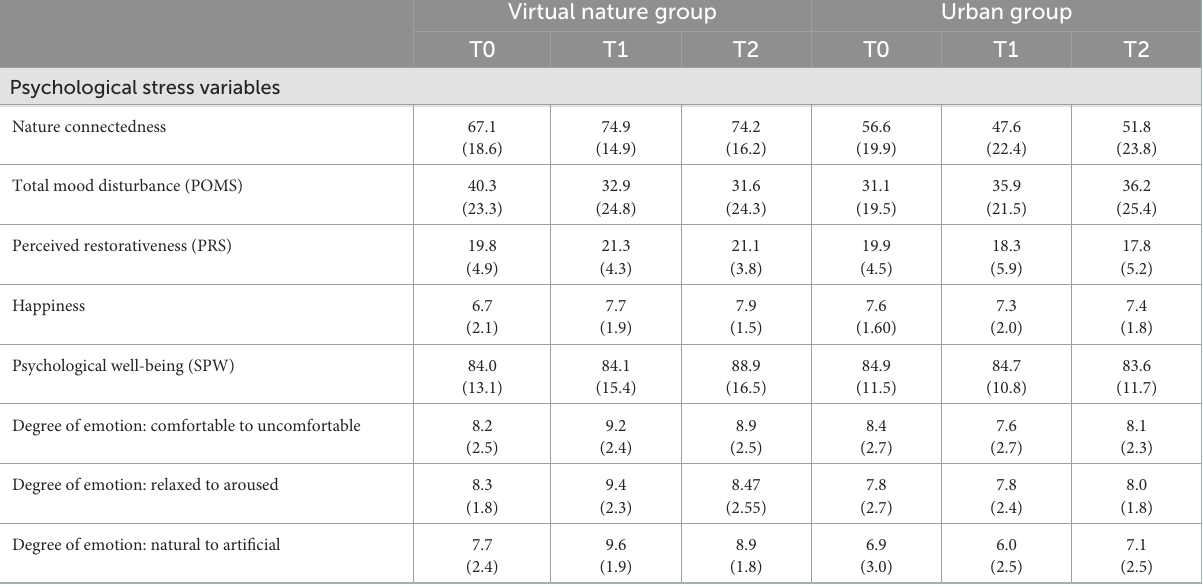
TABLE 1 Mean scores and standard deviations of the psychological stress of the virtual nature group and urban group at baseline (T0), week 3 (T1), and week 5 (T2). Virtual nature group